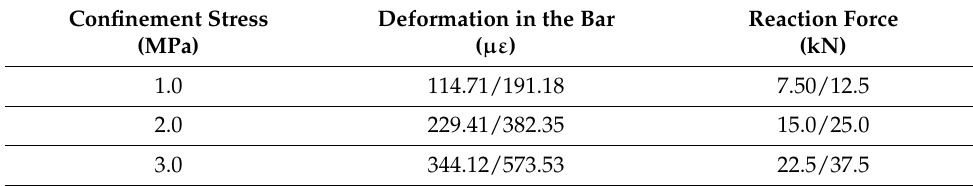
Table 7. Deformations required in the threaded